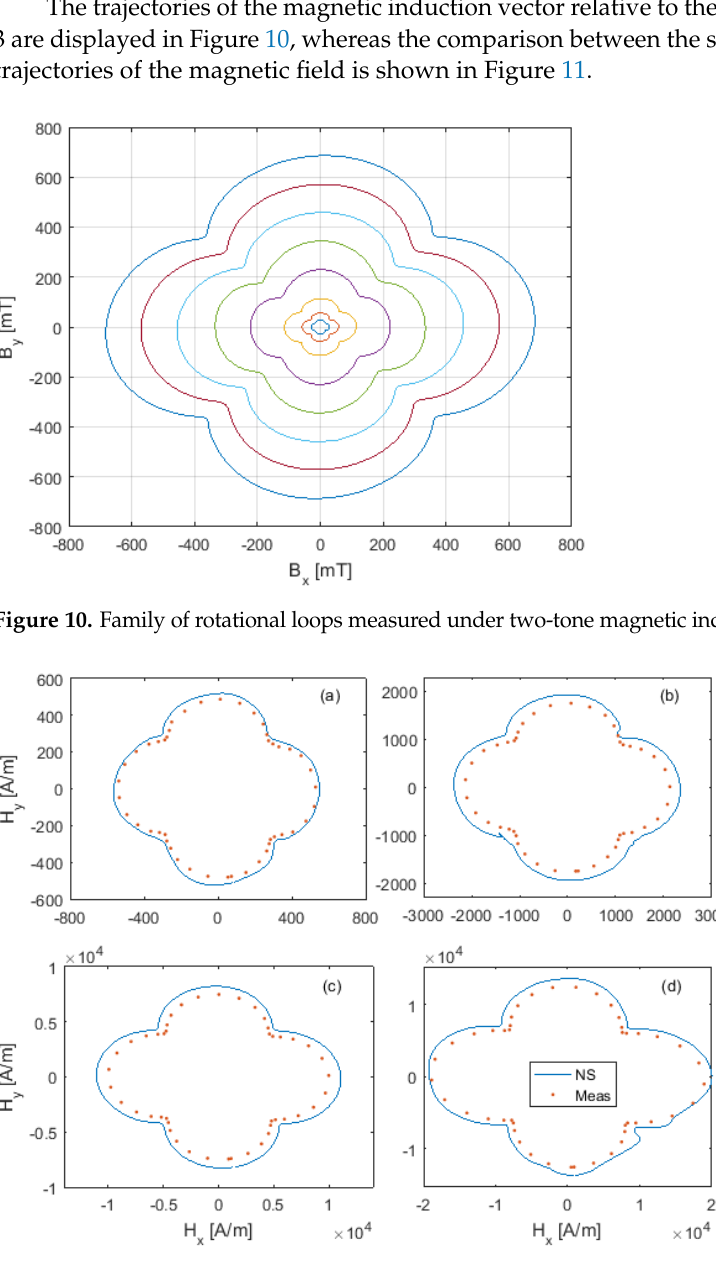
Figure 11. Comparison between simulated and measured trajectories of the H field relative to the rotational loops under two-tone magnetic inductions for different values of the amplitudes of the fundamental component B0 = 10 mT ( a ), B0 = 100 mT ( b ), B0 = 400 mT ( c ), and B0 = 600 mT ( d ).